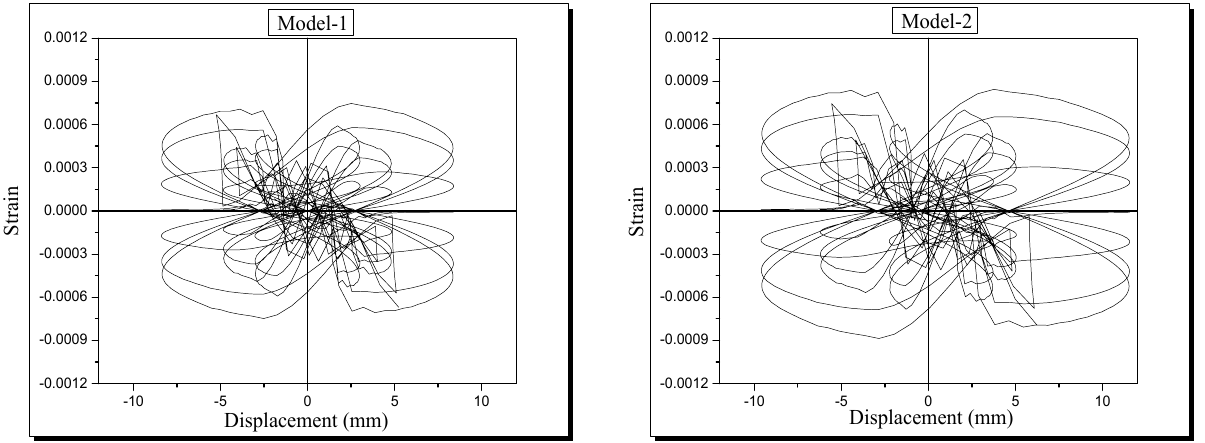
Figure 5: Strain Vs displacement on timber beam